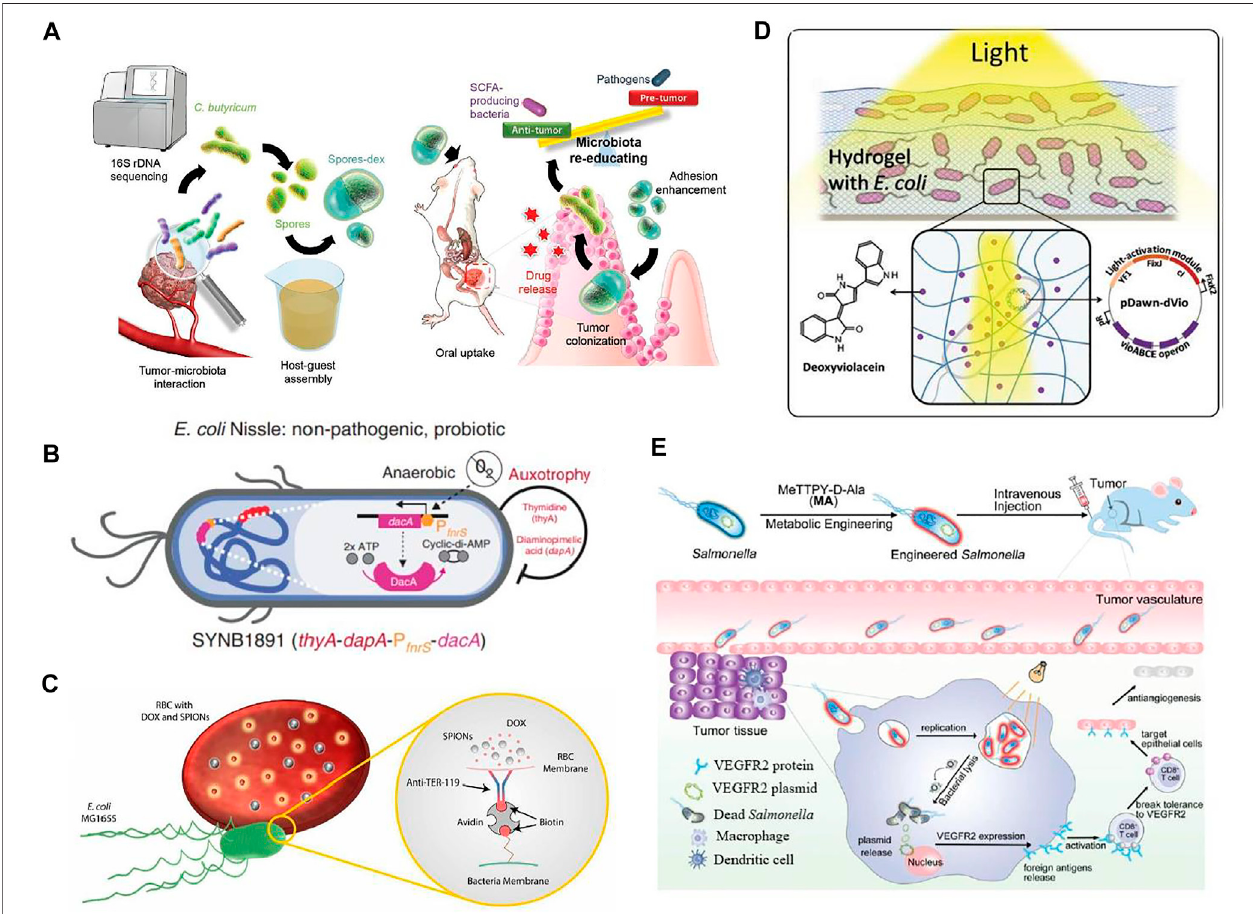
FIGURE 4 | Applications of engineered bacteria for tumor therapy. (A) The drug (dextran)-loaded spores provide antitumor activity. Reproduced with permission from Zheng et al. (2020), Copyright 2020, John Wiley and Sons. (B) The engineered E. coli Nissle referred to as SYNB1891 consists of a biocontainment system having dapA and the auxotrophies, PfnrS dacA circuit integrated into the dacA gene promotes anaerobically production of CDA. This CDA expression promotes an anti-tumor activationmechanism.Reproduced withpermissionfromLeventhal etal.(2020),Copyright2020,SpringerNature. (C) Themodi fi edstrainMG1655 consists ofred blood cells loadedwithdoxorubicin (DOX) andsuperparamagnetic ironoxide nanoparticles (SPIONs) attached tomodi fi ed motile E.coli bacterium via acomplex, biotin- avidin-biotin. Reproduced with permission from Alapan et al. (2018), Copyright 2018, American Association for the Advancement of Science. (D) The engineered E.coli has pDawn-dVio, a blue-light responsive optogenetic plasmid that has the potential to produce drug deoxyviolacein in presence of light. Reproduced with permission from Sankaran et al. (2019), Copyright 2018, John Wiley and Sons. (E) Salmonella encodes the VEGFR2 plasmid engineered with MA and promotes anti-angiogenesis therapy of breast cancer in vivo . Reproduced with permission from Liu et al. (2021), Copyright 2021, Royal Society of